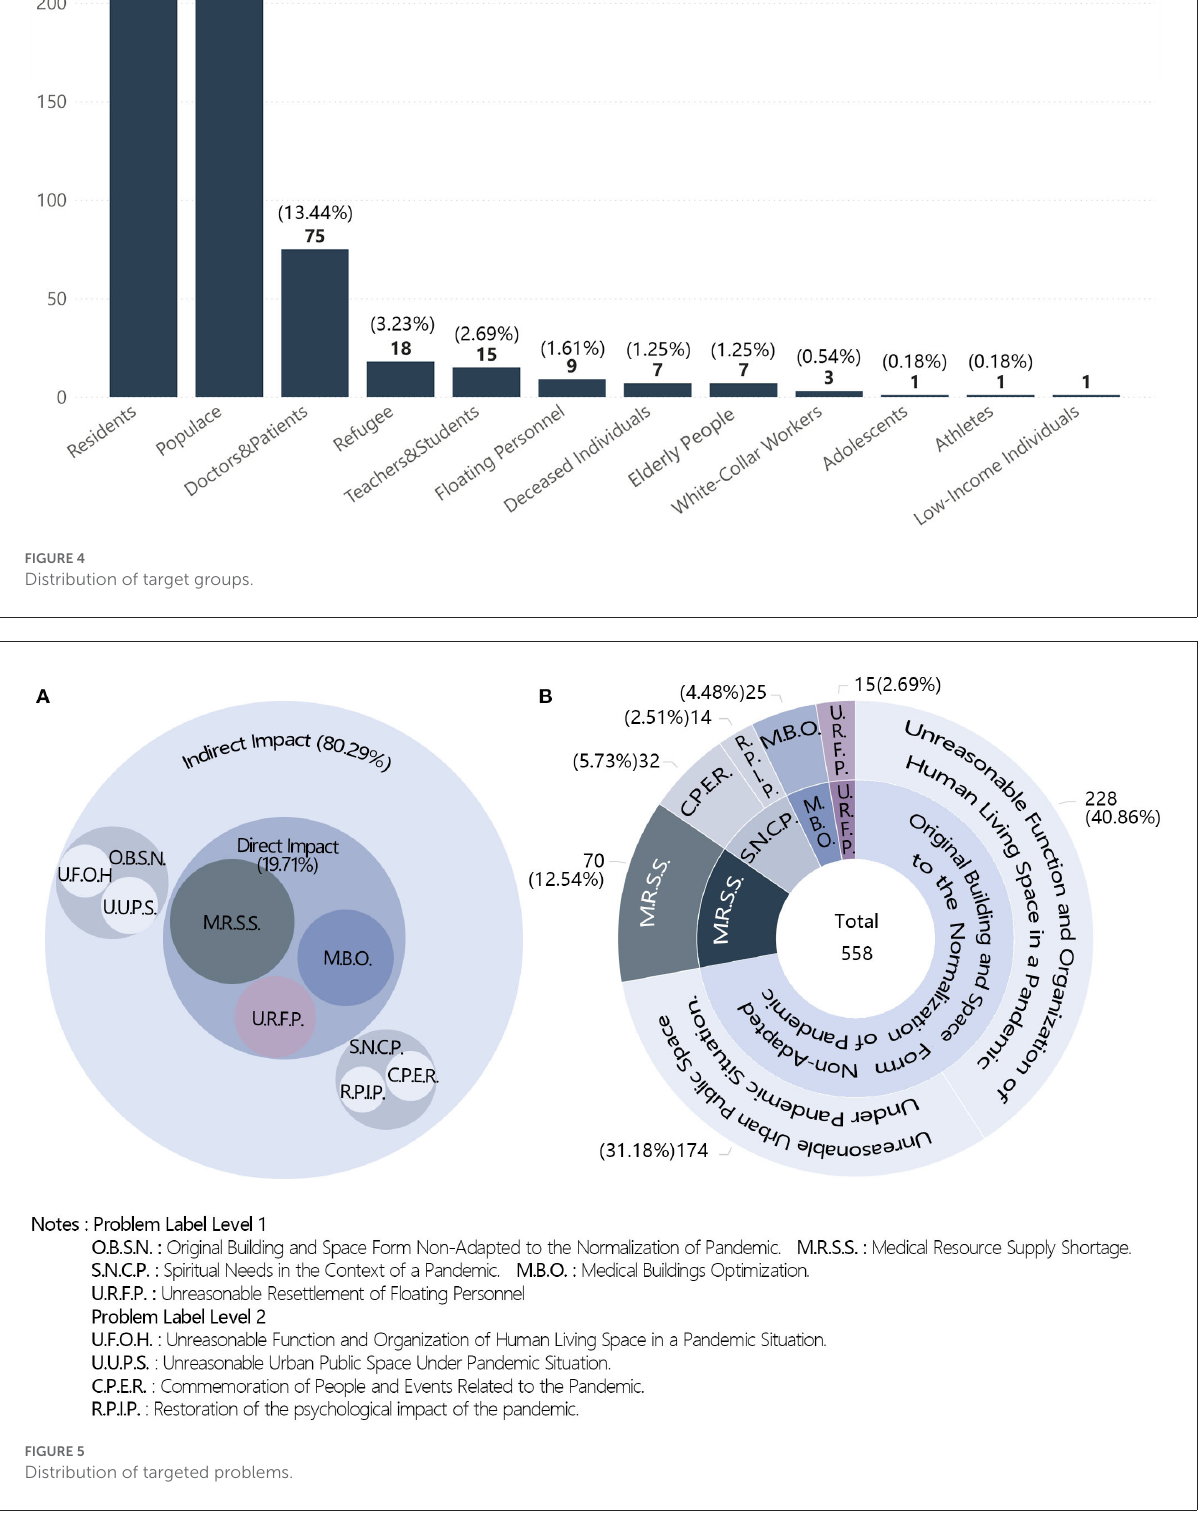
FIGURE5 Distribution of targeted